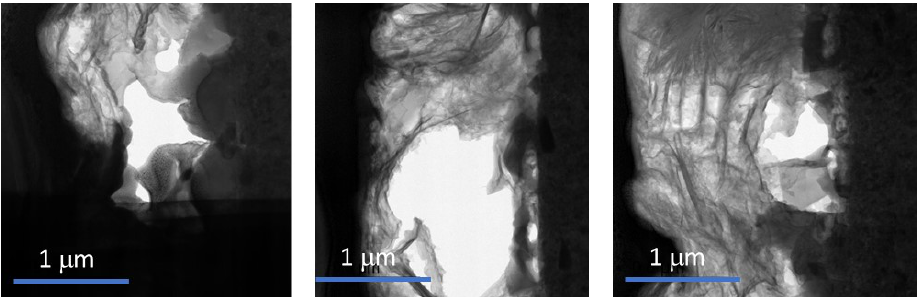
oxide scale by TEM in bright field (BF) mode [29].